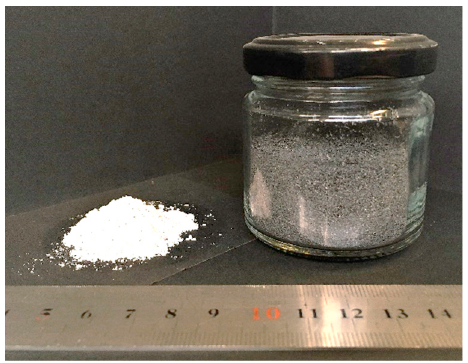
Figure 1. Mass of 2.50 g of limestone filler under 0.063 mm ( left ) and graphene nanoplatelets ( right ).